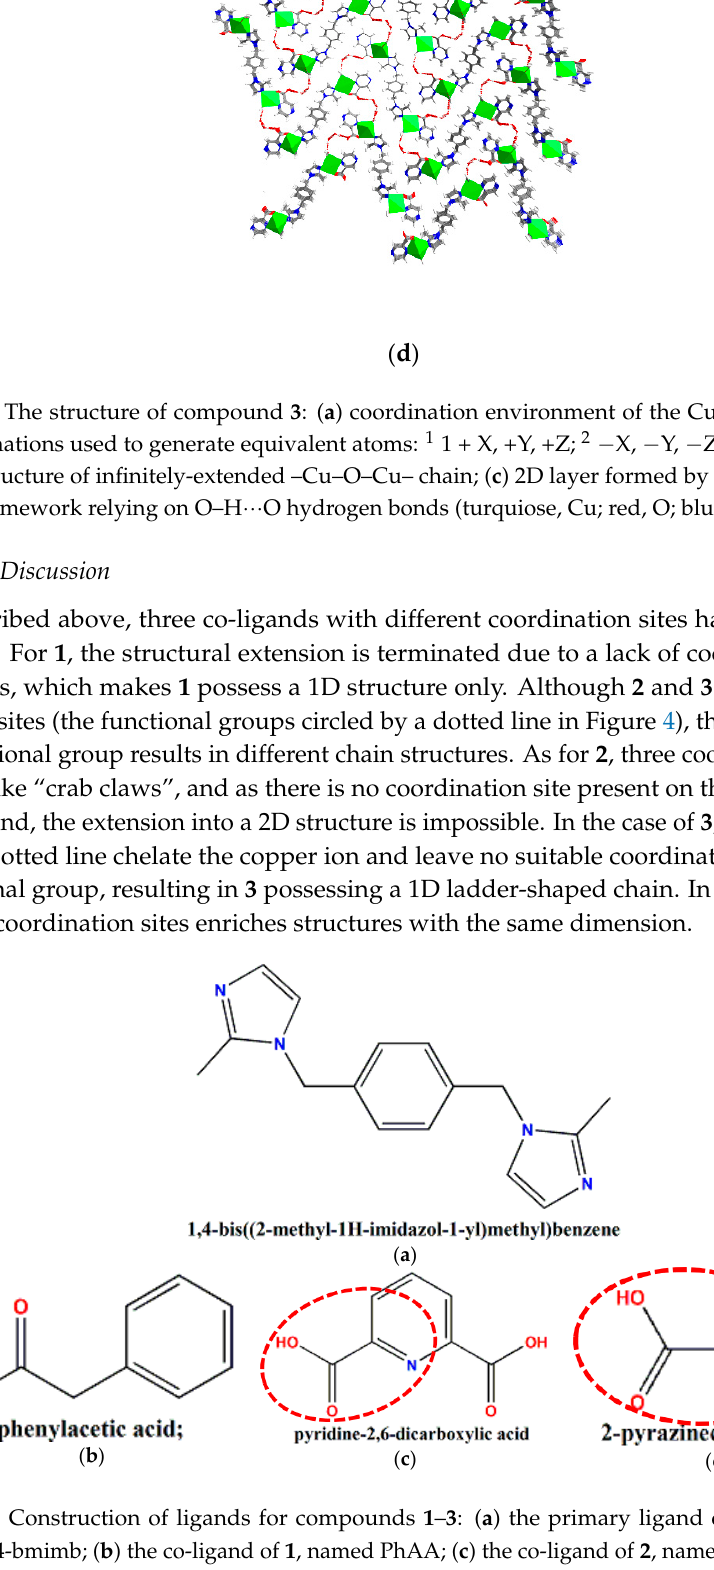
Figure 4. Construction of ligands for compounds 1 – 3 : ( a ) the primary ligand of compounds 1 – 3 , named 1,4-bmimb; ( b ) the co-ligand of 1 , named PhAA; ( c ) the co-ligand of 2 , named 2,6-PyDC; ( d ) the co-ligand of 3 , named 2-PAC. Red dotted lines indicate corresponding functional